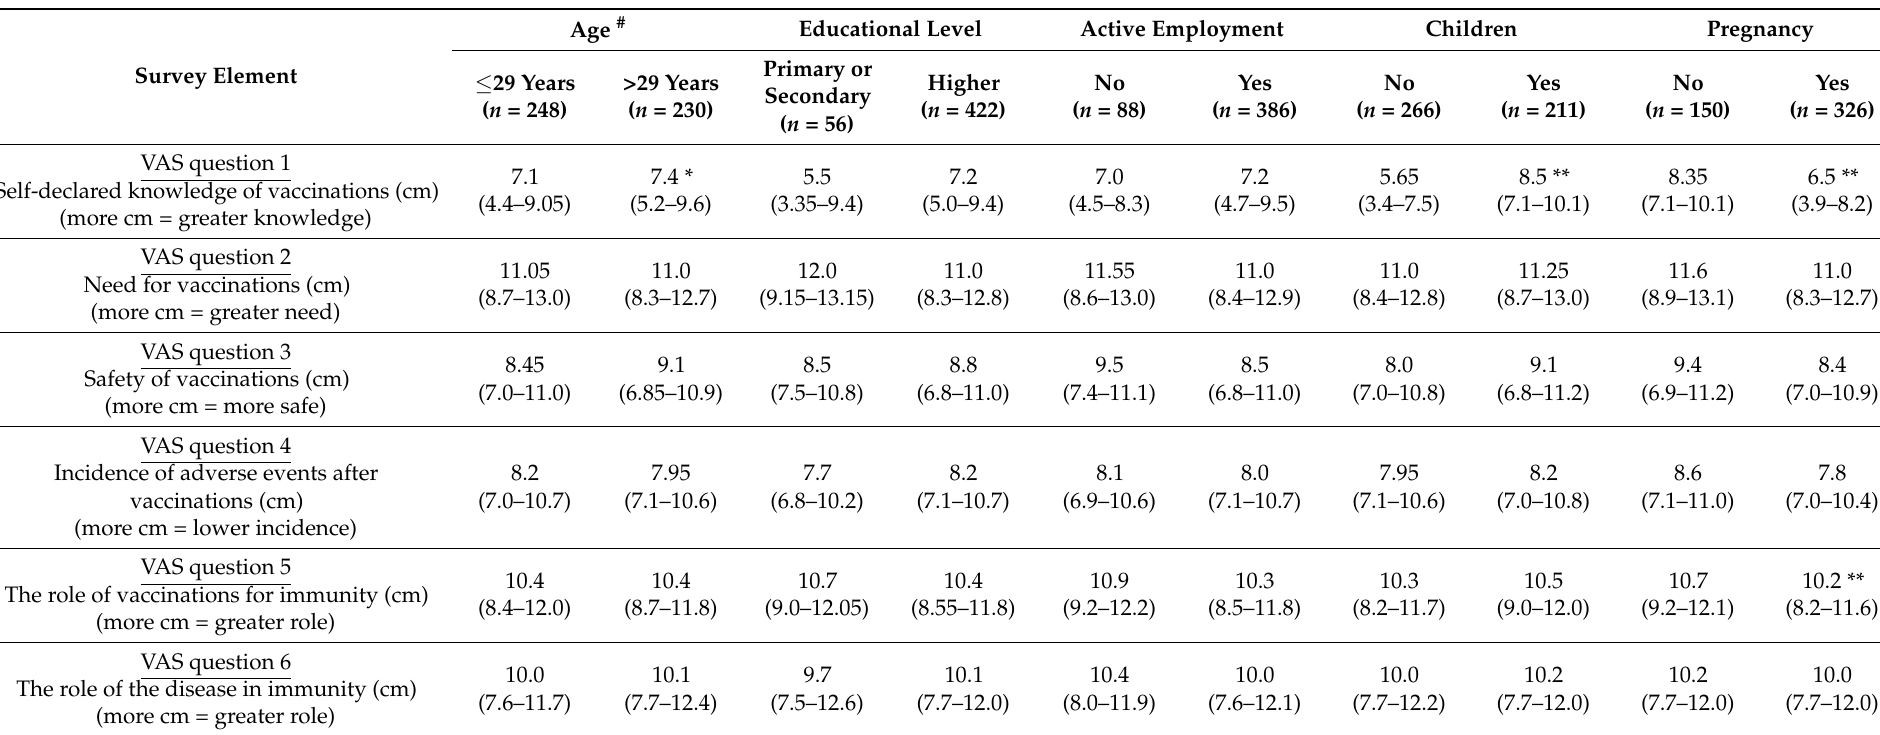
Table 1. Baseline self-declared knowledge of and attitudes towards vaccinations (visual analogue scales) according to sociodemographic